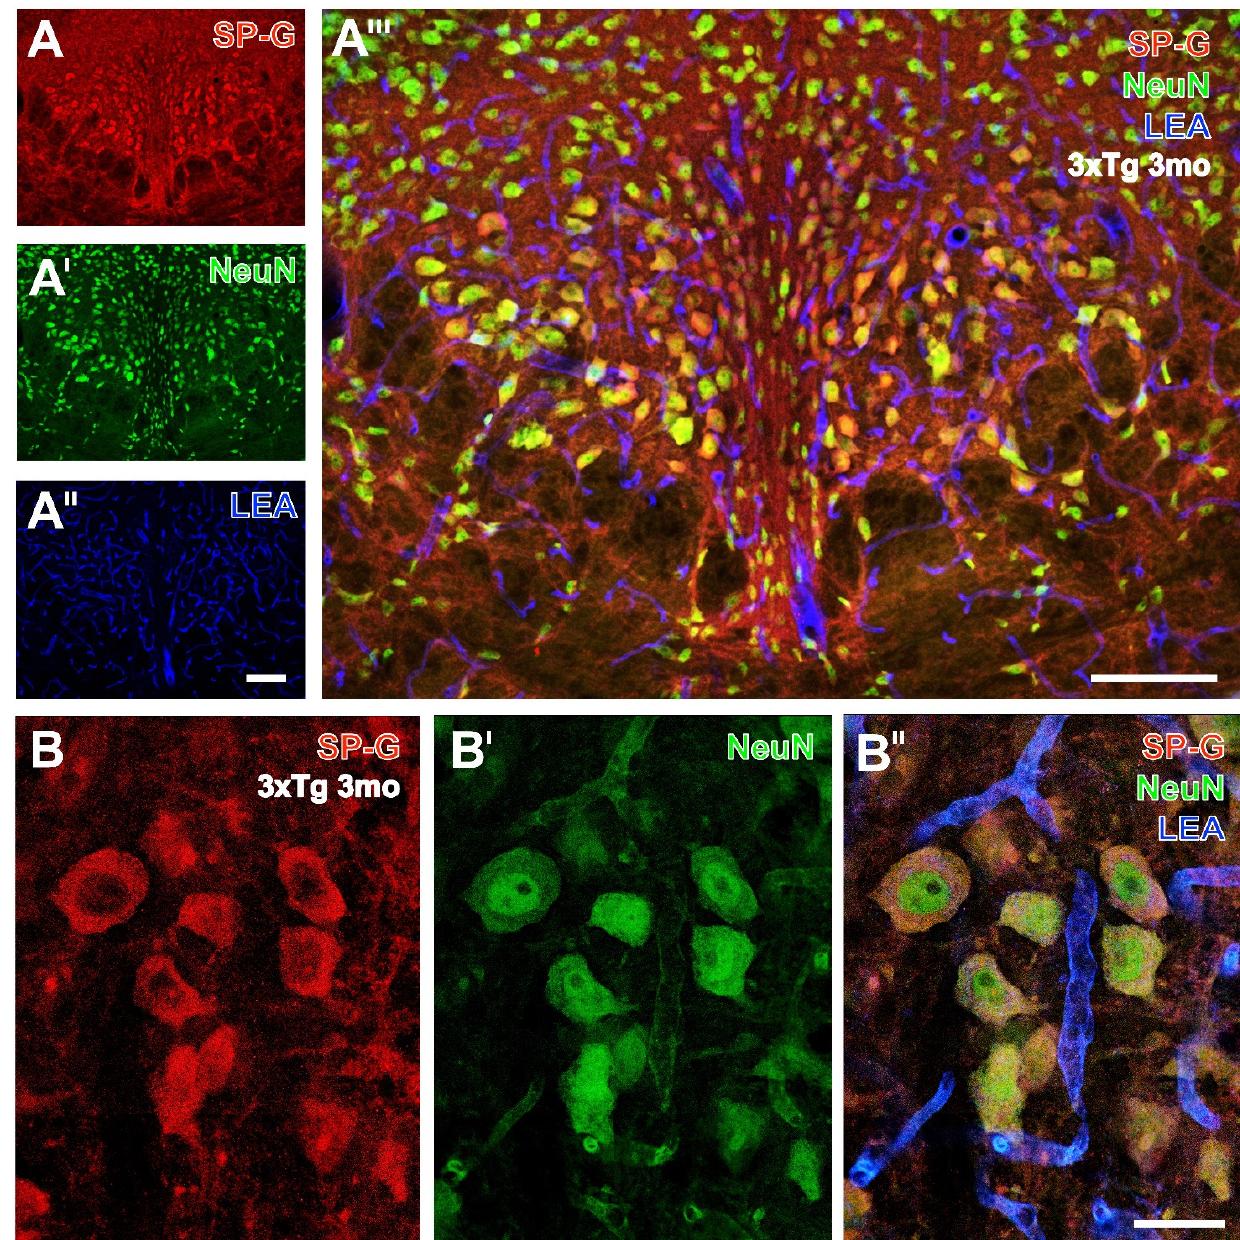
Figure 2. Triple fluorescence labeling of SP-G, LEA-positive vessels, and NeuN in the hypothalamus from a 3 month-old 3xTg mouse. Numerous SP-G-containing neurons of considerably differing sizes are visible in the medial hypothalamus around the posterior hypothalamic nucleus (and around the 3rd ventricle) in ( A ), while NeuN immunolabeling ( A’ ) reveals by nuclear staining even more nerve cells. Concomitant detection of LEA-binding sites ( A’’ ) shows evenly distributed vessels throughout the presented regions. In the overlay ( A’’’ ), a larger portion of neurons displays a green nucleus surrounded by a red SP-immunopositive rim. Notably, some neurons without cut nuclei appear red only. Higher magnified confocal laser scanning micrographs show SP-G-ir predominantly in the rim of nerve cells ( B ) co-expressing NeuN ( B’ ), which becomes even clearer in the overlay also show- ing the LEA-stained vasculature ( B’’ ). Scale bars: A’’ (also valid for A , A’ ) = 100 µm, A’’’ = 100 µm, B’’ (also valid for B , B’ ) = 25 µm.